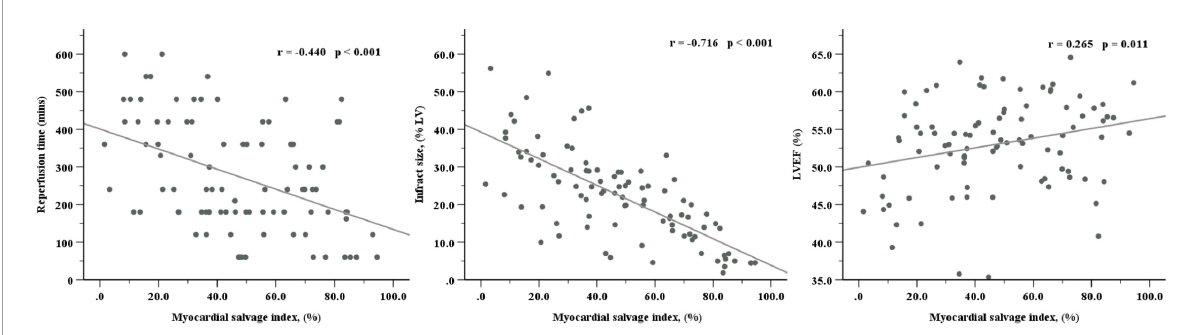
FIGURE3 Correlations of myocardial salvage index with reperfusion time, infarct size, and LVEF. LVEF, left ventricular ejection fraction.